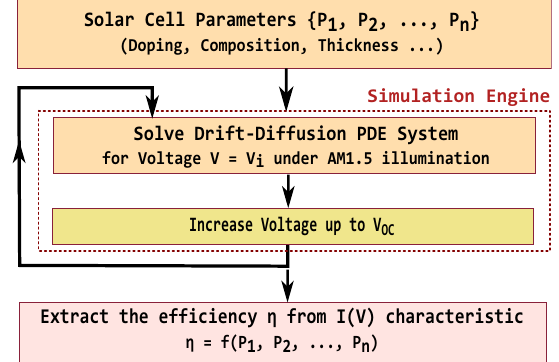
Fig. 2. The procedure used for extracting the solar cell ef fi ciency by solving the coupled Poisson and continuity PDE system for voltage ranging from 0 to V OC , the